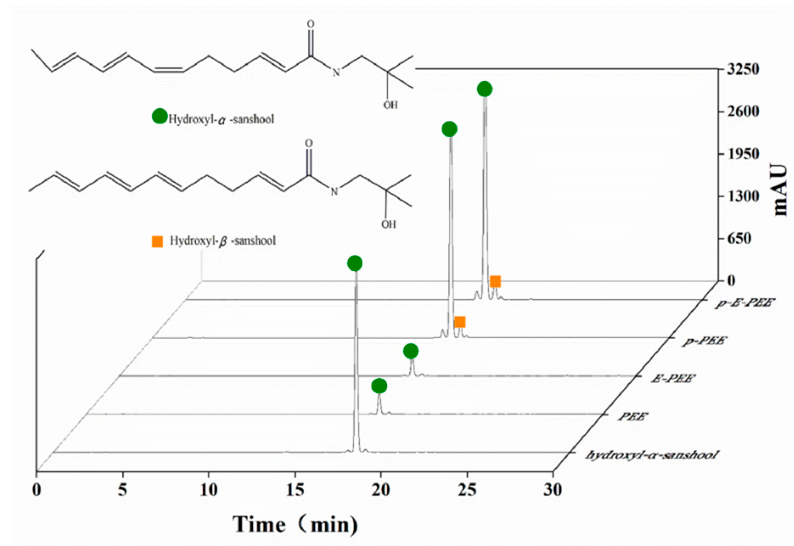
Figure 4. HPLC analysis of hydroxyl- α -sanshool standard and samples.